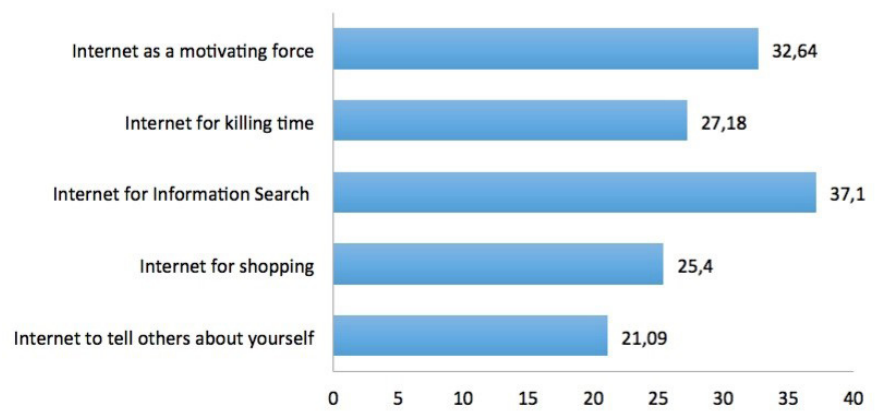
Figure 1. Representation of informational behavior strategies in the student